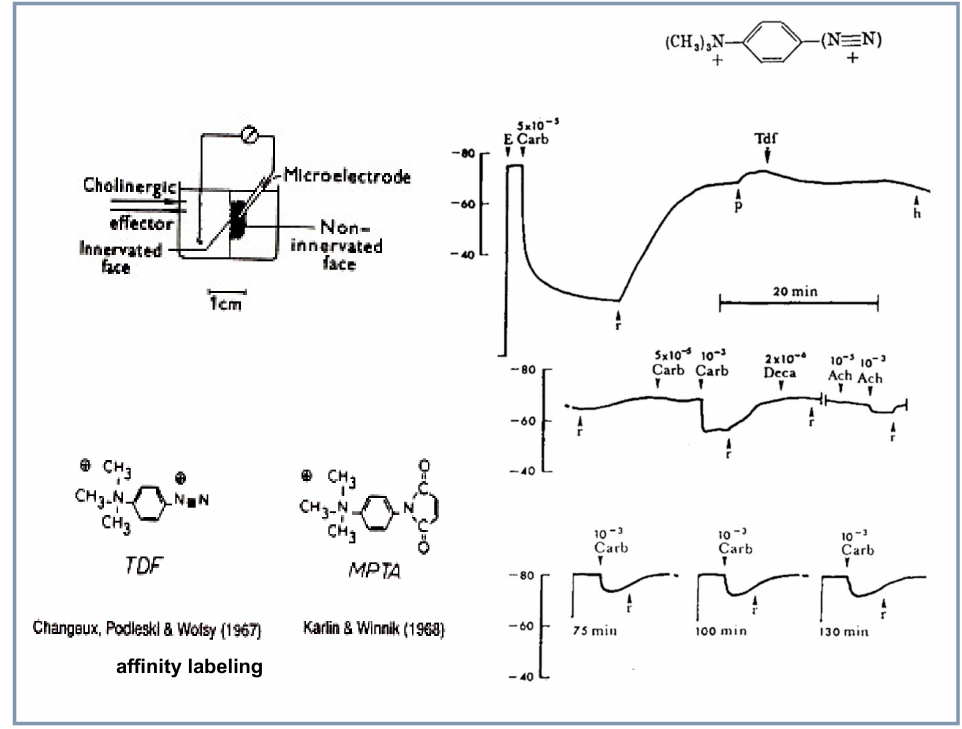
Figure 4. The method of a ffi nity labeling of the nAChR using p -(trimethylammonium) benzene diazonium difluoroborate (TDF) with E. electricus electroplaque (reproduced from